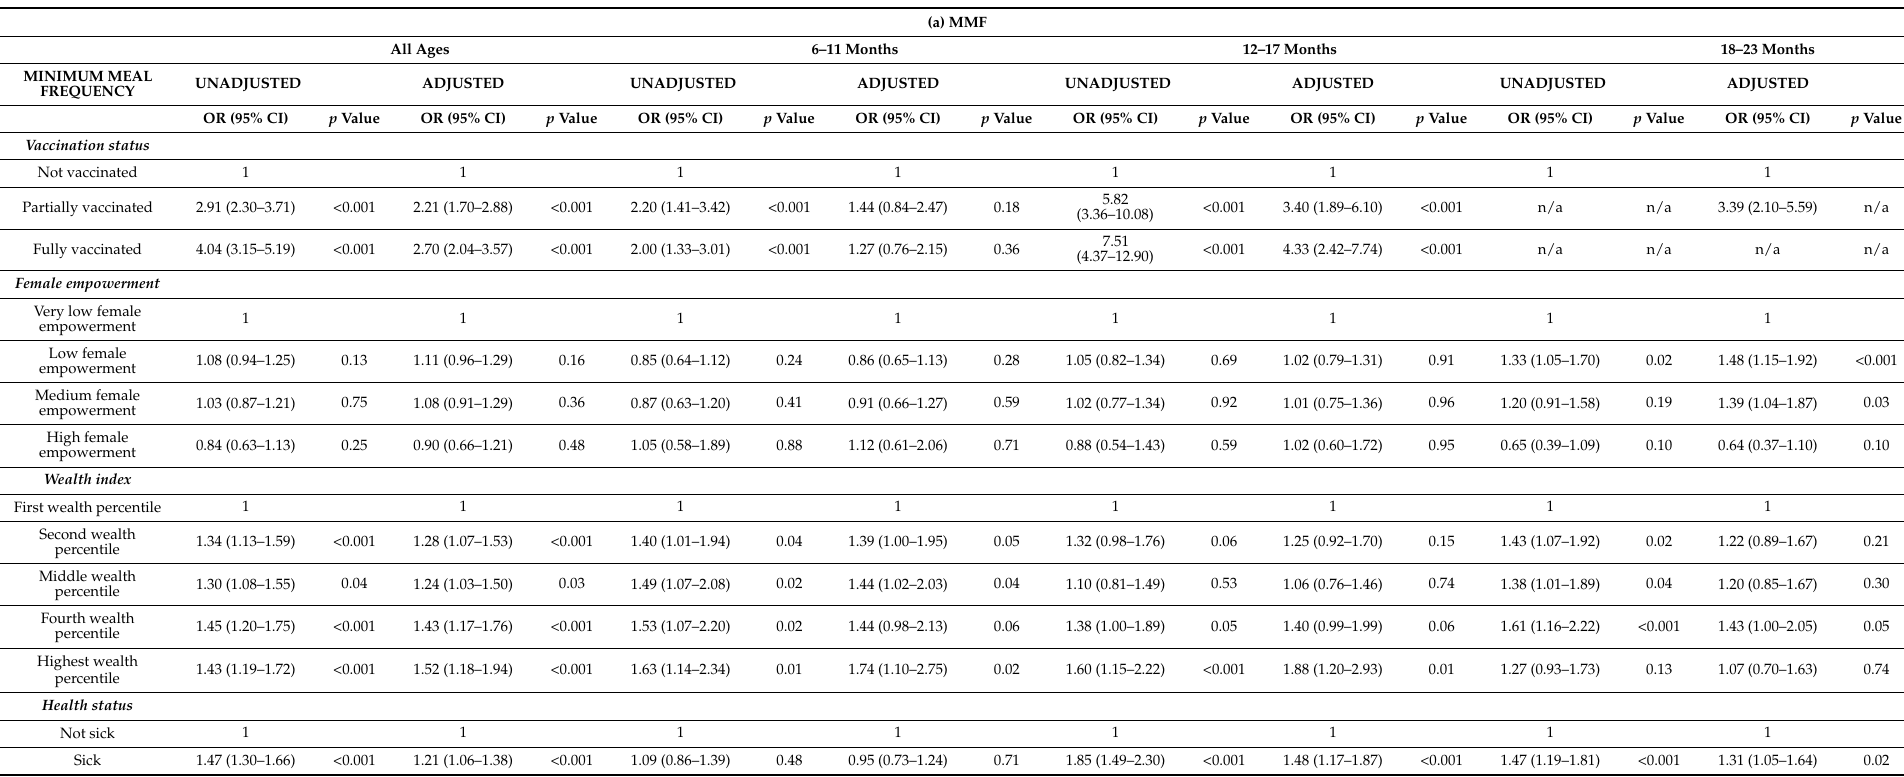
Table 5. Unadjusted and fully adjusted models for the MMF and MDD indicators for all age groups and stratified by the three age groups 6–11 months, 12–17 months and 18–23 months (a,b). The results in the table were obtained considering missing values as zero. (a) MMF: Unadjusted and fully adjusted models for the MMF indicator for all age groups and stratified by age; (b) MDD: Unadjusted and fully adjusted models for the MDD indicator for all age groups and stratified by